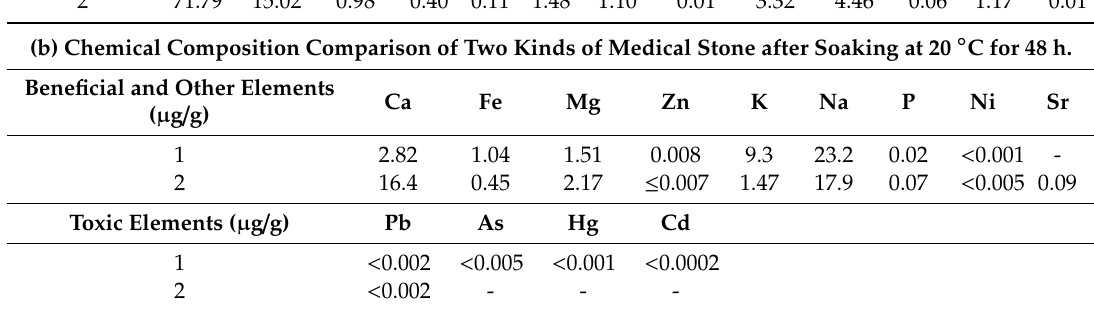
Table 1. Comparison of two kinds of medical stone. (a) Comparison of Macroelements of Two Kinds of Medical Stone (%). Components SiO 2